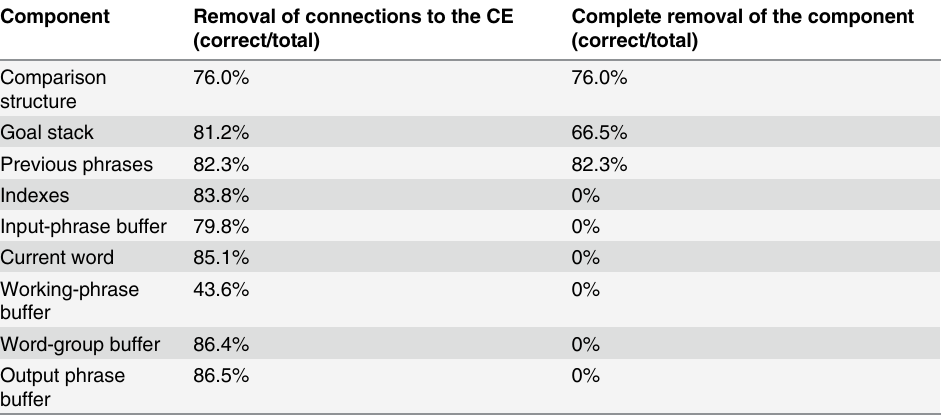
Table 6. Percentage of correct answers after removal of the connections from the STM components to the central executive, and after complete removal of the components. The values are averaged over the three datasets people, parts of the body and categorization, and over the four rounds of the cross valida- tion. The percentage of correct answers with all components and with all connections is 86.5%.